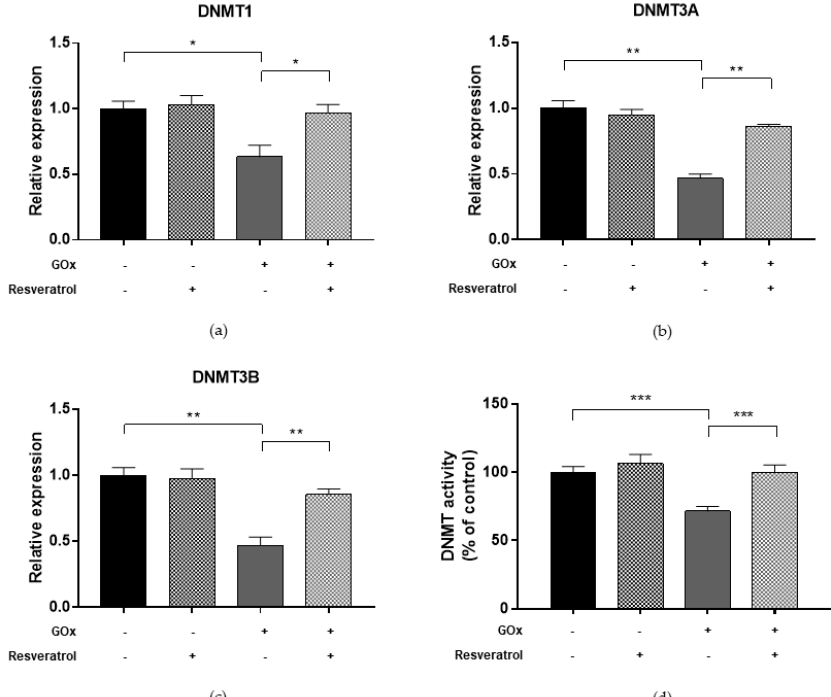
Figure 2. DNA methyltransferase (DNMT) expression and activity in ARPE-19 cells under oxidative stress. ( a – c ) Analysis of gene expression showed that treatment with 25 mU/mL GOx for 24 h downregulated DNMT1, DNMT3A, and DNMT3b expression levels (FC = 0.63, FC = 0.47, and FC = 0.46, respectively; p -values < 0.05). ( d ) Analysis of total DNMT enzymatic activity using a colorimetric assay confirmed that total DNMT activity was reduced by 28.5% in GOx-treated cells compared to controls ( p < 0.0001). Treatment with 10 µM resveratrol for 24 h restores DNMT expression (FC = 0.97, p = 0.039 for DNMT1; FC = 0.86, p = 0.005 for DNMT3A; FC = 0.85, p = 0.008 for DNMT3B) and activity (99.9%, p = 0.001) in cells under oxidative stress. The experiments were performed in triplicate and repeated three times. Bar graphs show mean ± SE. * p < 0.05, ** p < 0.01, *** p < 0.001 based on the Student’s t -test.